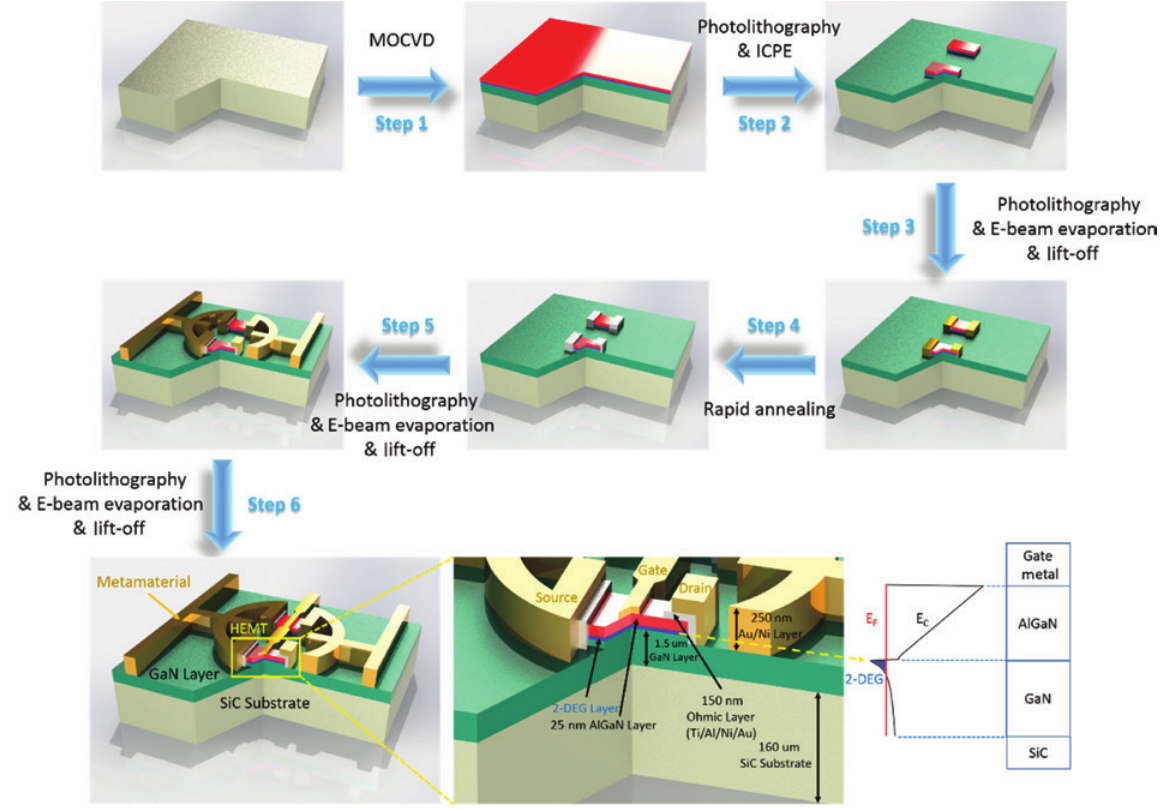
Figure 2: Process flow for the fabrication of enhanced resonant metamaterial embedded with the nanostructured 2DEG